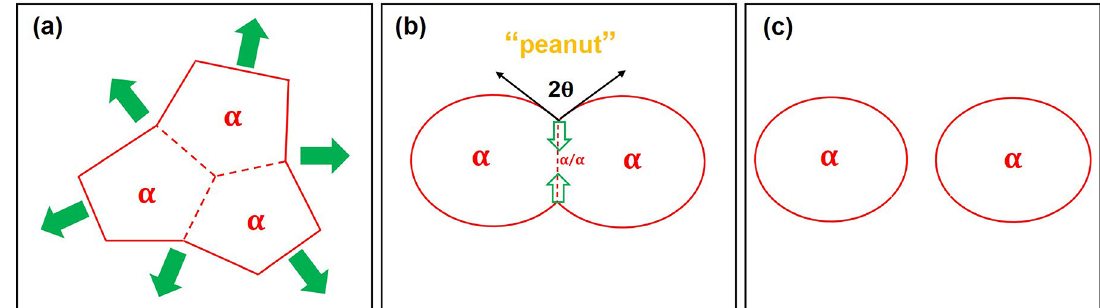
Figure 6. The Schematic diagram of: (a) growth by merging, (b) boundary splitting and (c) the completion of boundary